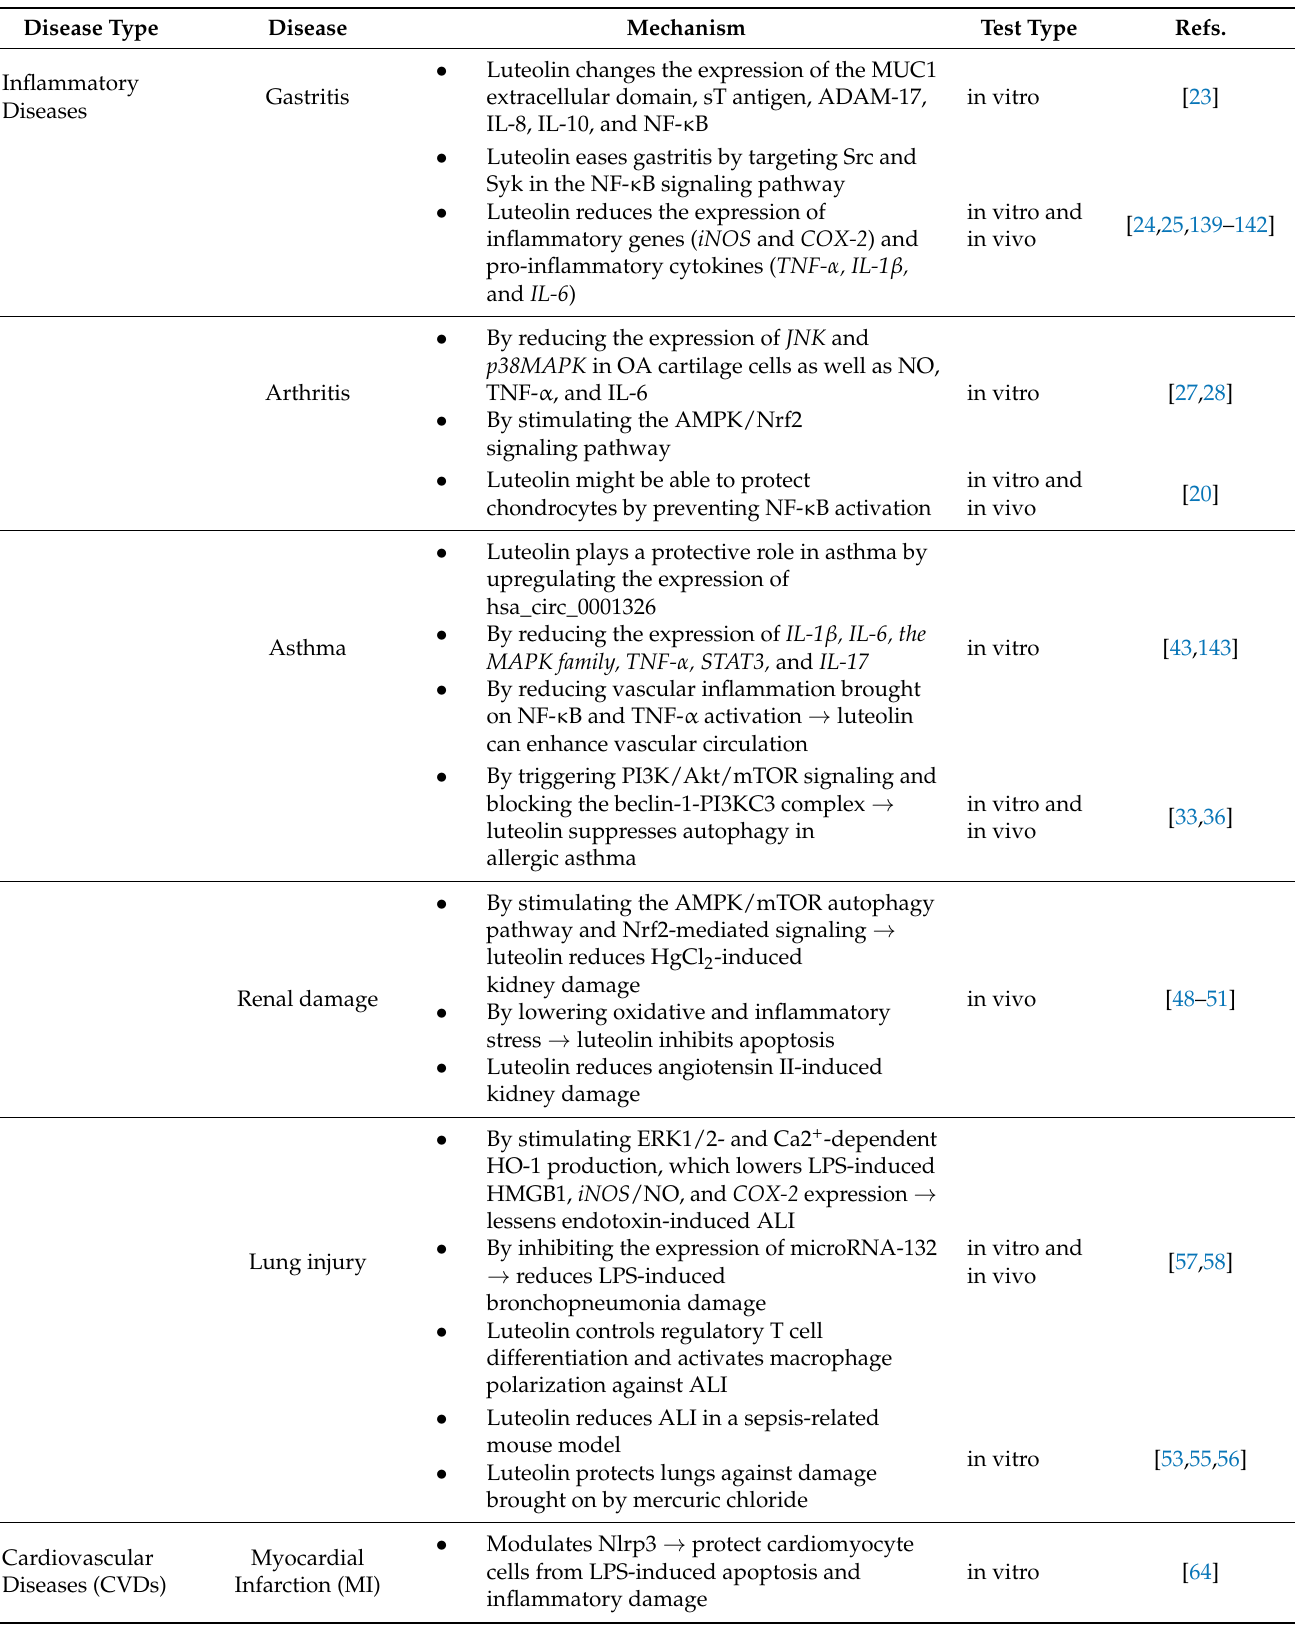
Table 1. The mechanism of luteolin in various